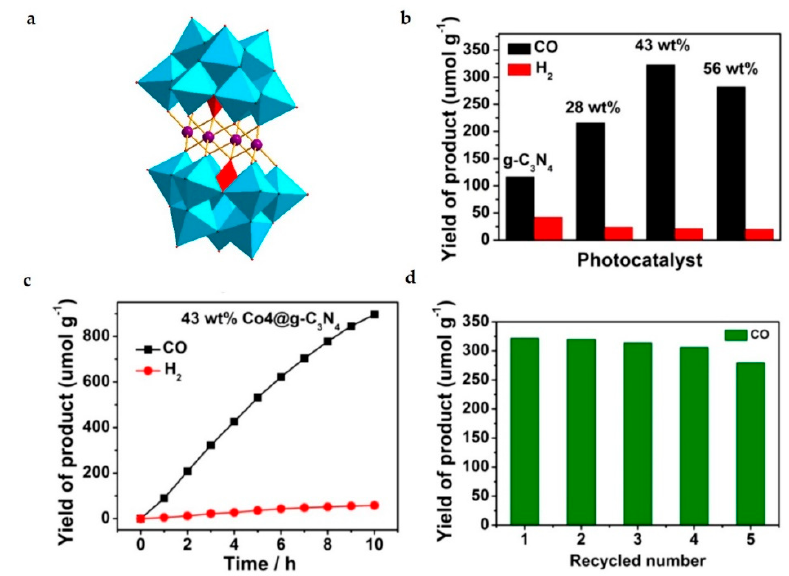
Figure 6. The photoreduction of CO 2 by the Co 4 @g-C 3 N 4 hybrid material. The structure of Na 10 [Co 4 (H 2 O) 2 (PW 9 O 34 ) 2 ]; color code: WO 6 octahedron, light blue; PO 4 tetrahedron, red; Co, purple ball; O, red ball. ( a ). The photocatalytic activity of different photocatalysts ( b ). Time course of the CO and H 2 ( c ). Recycling experiments ( d ). Reprinted with permission from [44]. Copyright © 2017 American Chemical Society.